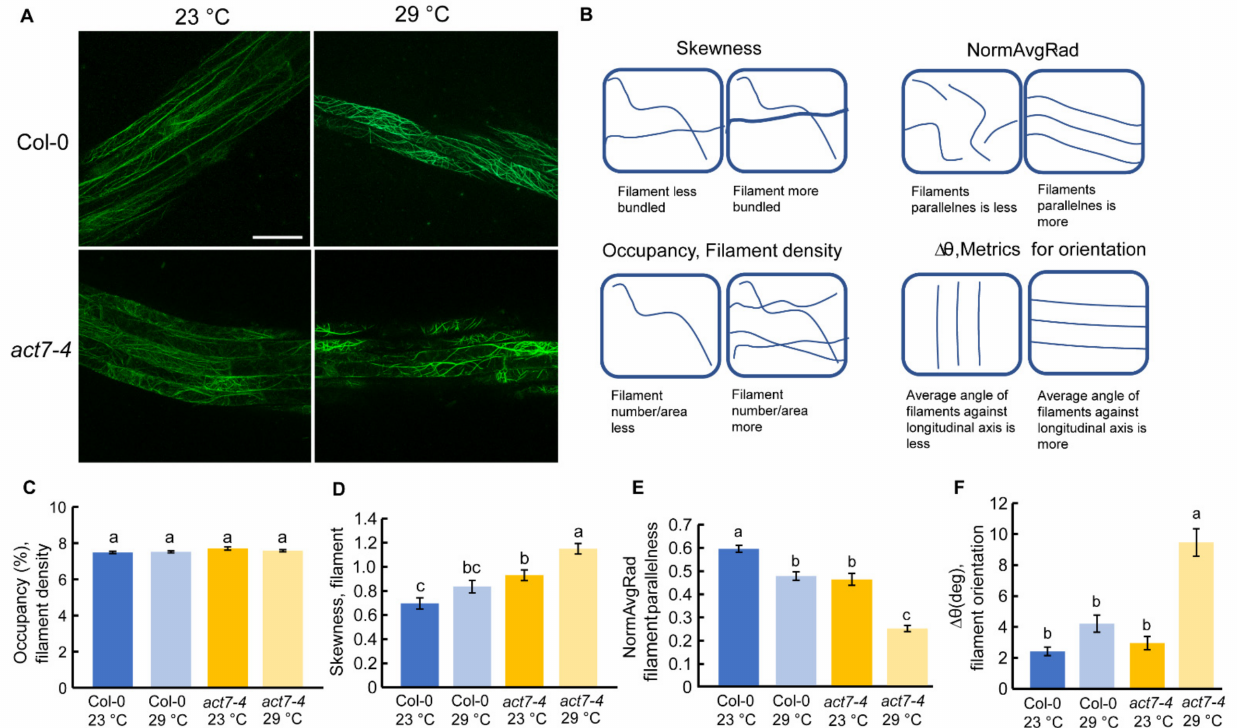
Figure 2. Effect of prolonged moderate-high temperature stress on cellular actin organization in Col-0 and act7-4 . ( A ) Con- focal images of ABD2-GFP and act7-4 ABD2-GFP at 23 and 29 ◦ C (Bars = 50 µ m). ( B ) Schematic representation of quantified actin parameters. Quantification of actin filaments ( C – F ). ( C ) Percent occupancy, ( D ) Skewness, ( E ) NormAvgRad, and ( F ) ∆ θ in degree. Five-day-old seedlings were transferred to new agar plates and subjected to high-temperature (29 ◦ C) and control temperature (23 ◦ C) treatment for 3 days under light condition. Vertical bars represent mean ± SE of the experimental means from at least three independent experiments (n = 3 or more), where experimental means were obtained from 30 to 50 cells. Comparisons between multiple groups were performed by analysis of variance (ANOVA) followed by the Tukey–Kramer test. The same letter indicates no significant differences ( p <